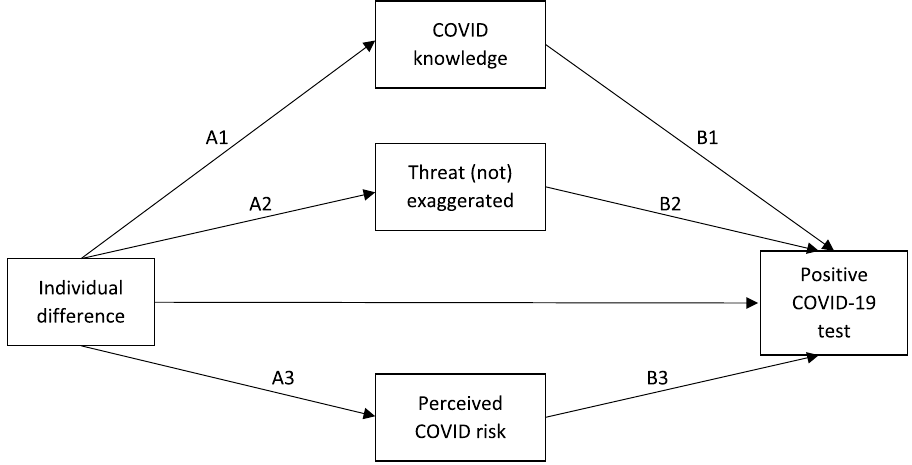
Figure 1. Basic structure of mediational models predicting impact of individual difference variables on positive COVID-19 tests via COVID-specific variables.